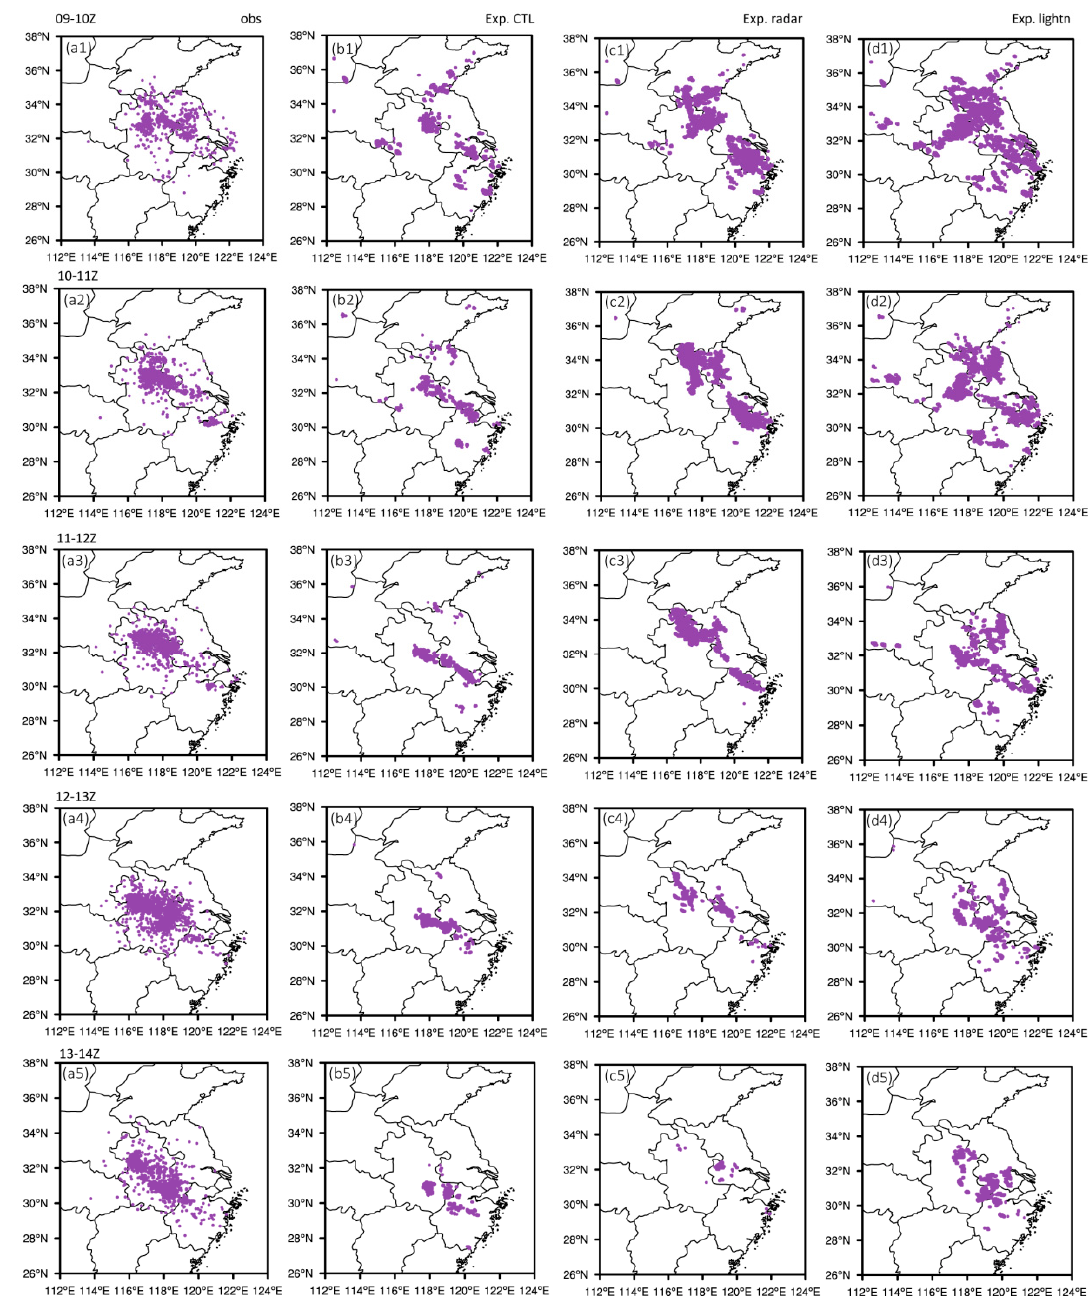
Figure 5. The observed cloud-to-ground lightning location ( a ) and diagnosed cloud-to-ground lightning location of ( b ) Exp. CTL, ( c ) Exp. radar and ( d ) Exp. lightn from 0900 to 1400 UTC. Row 1 to 6 represents different time point from 1000 to 1500 UTC.